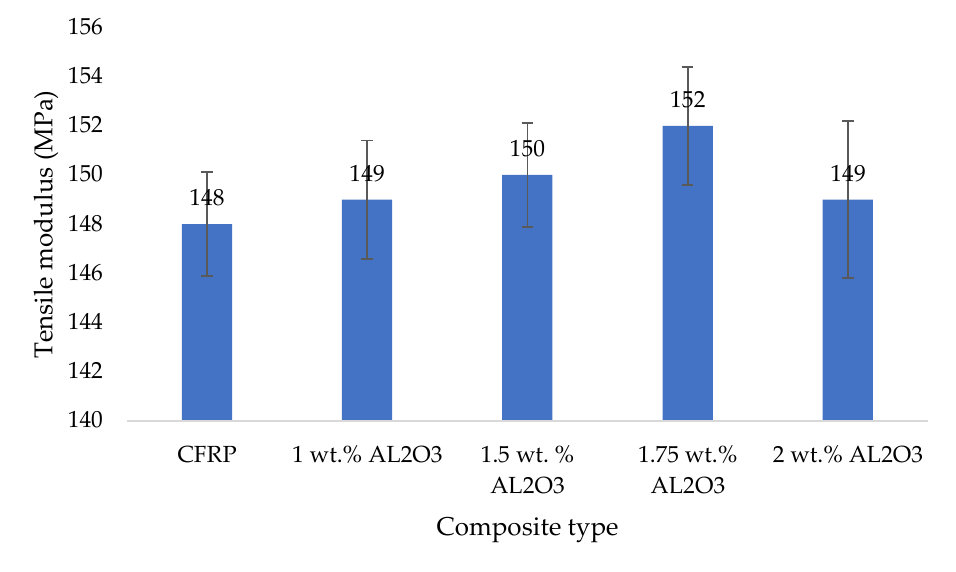
2 O 3 nano-composites.